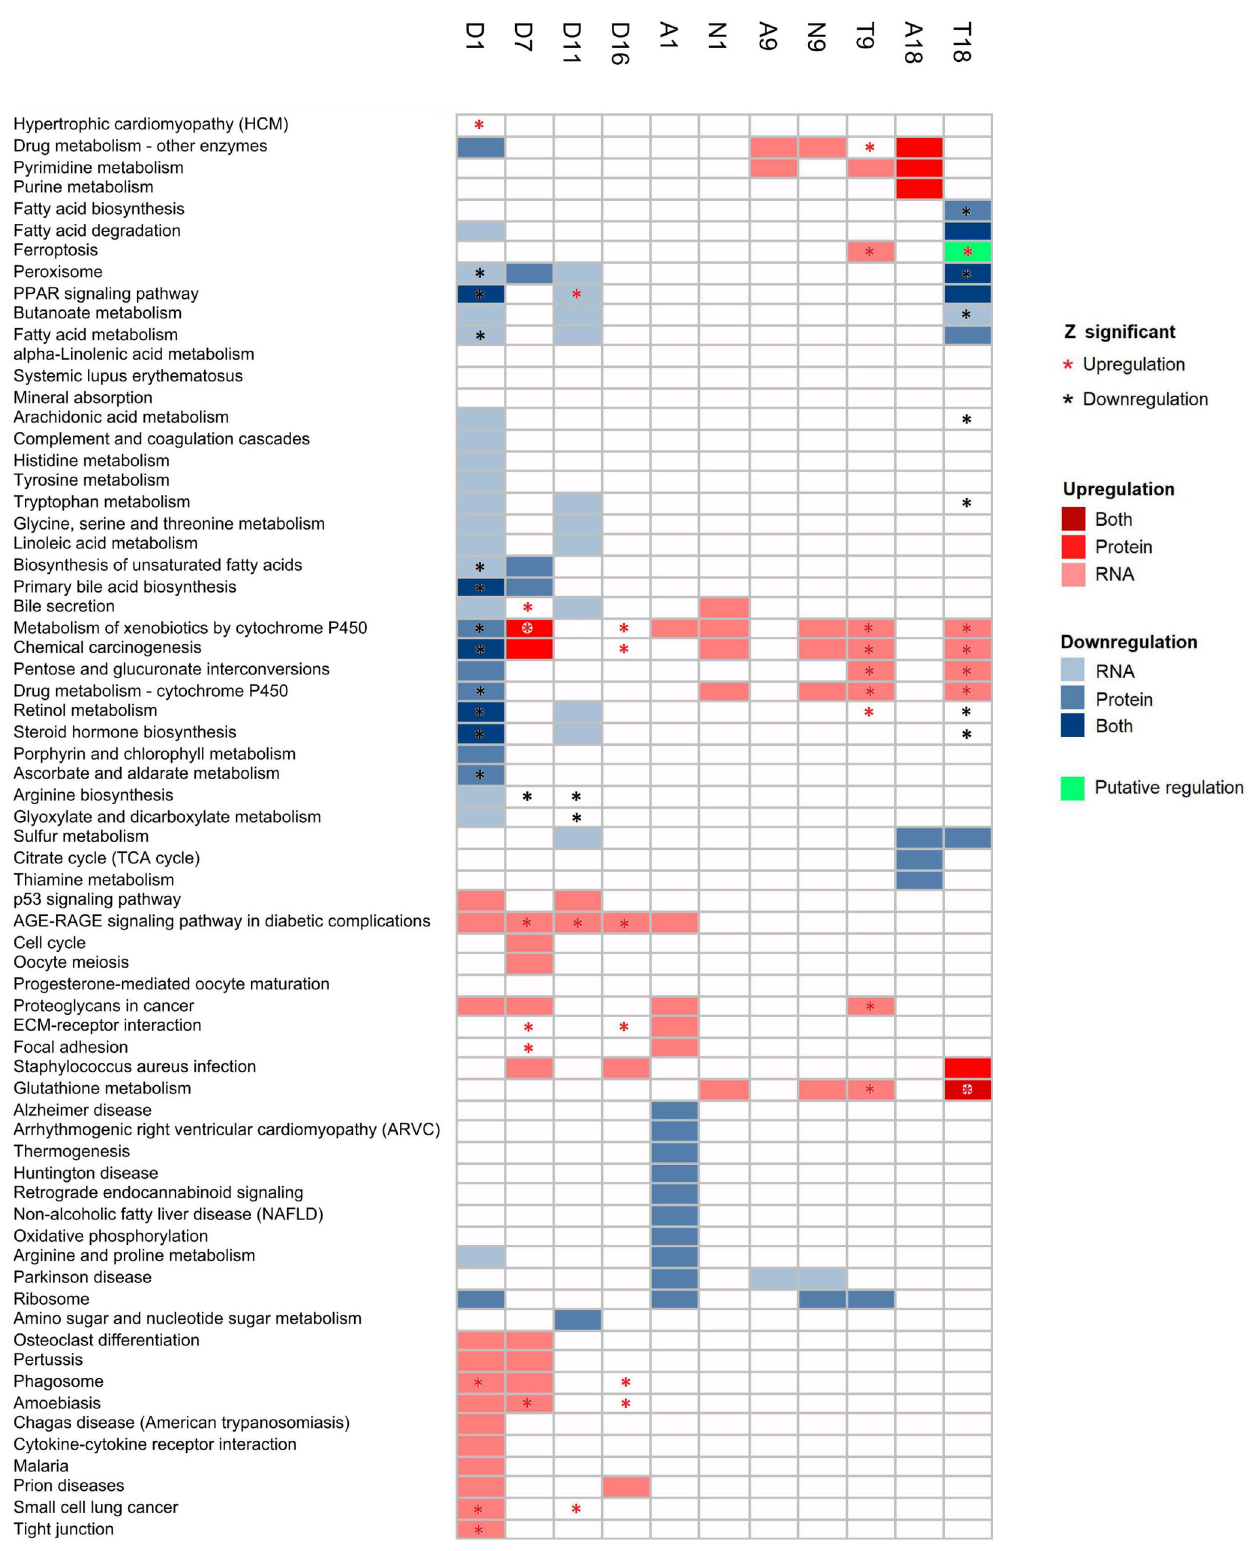
Fig 3. Pathway over-representation-based Integration using Biological level expression (PIB) and Stouffer sum Z. Statistically significant pathways are shown in a grid with cells in a color corresponding to upregulation (red scale) or downregulation (blue scale). Pathways with weighted Z score < 0.05 are shown with an asterisk, red if the pathway was upregulated and black if it was downregulated.